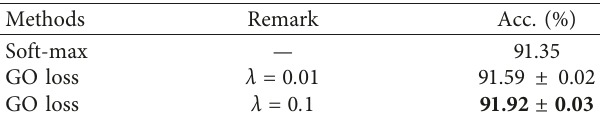
Table 5: Classification accuracy with ResNet-20 on CIFAR-10 dataset.